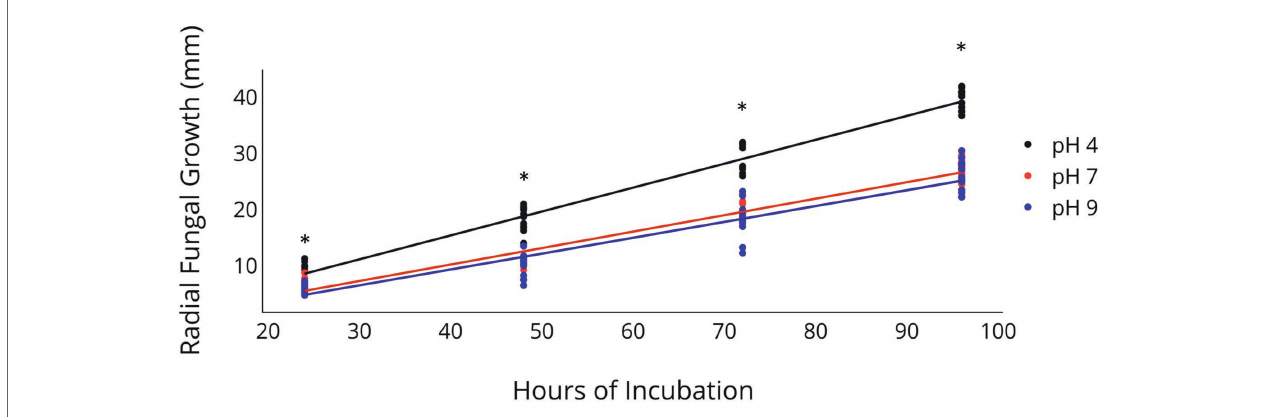
FIGURE 1 | Radial Growth of C. jacksonii in response to medium pH. Radial growth of two C. jacksonii isolates on PDA at a pH of 4, 7, and 9. Colony diameter was measured 24, 48, 72, and 96 h after subculturing, and the study was repeated twice over time. No isolate or run differences were observed, so the results were combined. The black trendline indicates growth rate at pH 4 ( p < 0.0001, y = 0.426 x − 1.66, R 2 = 0.955), the orange trendline growth at pH 7 ( p < 0.0001, y = 0.293 x − 1.53, R 2 = 0.953), and the blue trendline growth at pH 9 ( p < 0.0001, y = 0.283 x − 1.98, R 2 = 0.899). The impact of pH on radial growth was assessed at each rating date and the * indicates significance at the p < 0.05 level using Fisher’s least significant